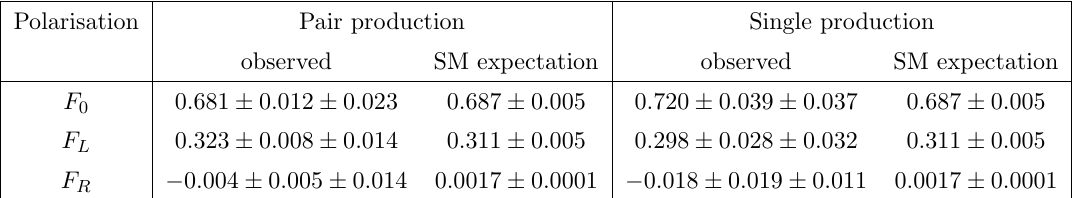
Table 2 . W polarisations fractions from top decay measured at CMS for processes of pair [28] and single top [29] production at the 8 TeV LHC, together with the SM expectation [30]. The quoted experimental uncertainties correspond to the statistical and systematic errors